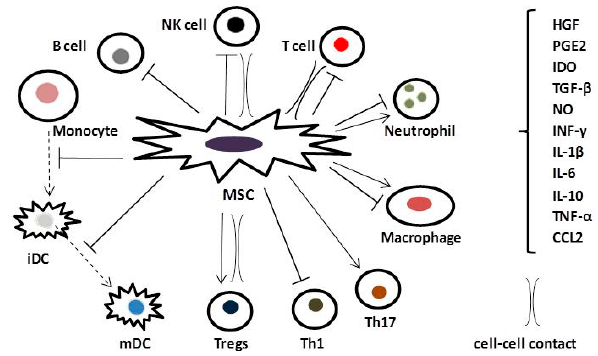
Figure 1. Effects of MSCs on generation, maturation, and proliferation of monocyte-derived immature (iDC) and mature dendritic cells (mDC) mediated via prostaglandin E2 (PGE2), transforming growth factor- β (TGF- β ), interleukin (IL)-6; stimulation of T regulatory cells (Tregs) via PGE2, TGF- β , IL-10, cell-cell contact; inhibition of T helper (Th) cells subtype 1 (Th1) via PGE2; stimulation of Th17 cells via PGE2; macrophage differentiation via PGE2; multifaceted regulation of neutrophils via IL-6; downregulation of T cells induction, proliferation and function via PGE2, TGF- β , IL-1 β , IL-6, IL-10, interferon- γ (INF- γ ), indoleamine-pyrrole 2,3-dioxygenase (IDO), hepatocyte growth factor (HGF), nitric oxide (NO), cell–cell contact; inhibition of natural killer (NK) cells via PGE2, TGF- β , INF- γ , cell–cell contact; inhibition of B cells via INF- γ , chemokine (C-C motif) ligand 2 (CCL2); dash arrow: cell differentiation; solid arrow: stimulation; T-bar: inhibition.